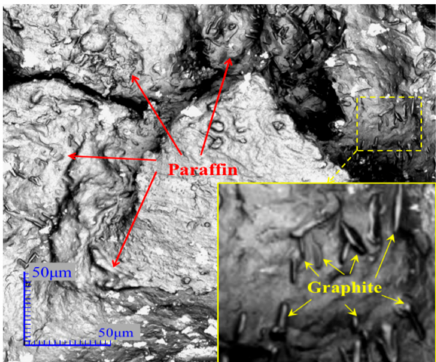
Figure 6. Laser confocal scanning microscope (LSCM) image of graphite distributed in SSPCM.